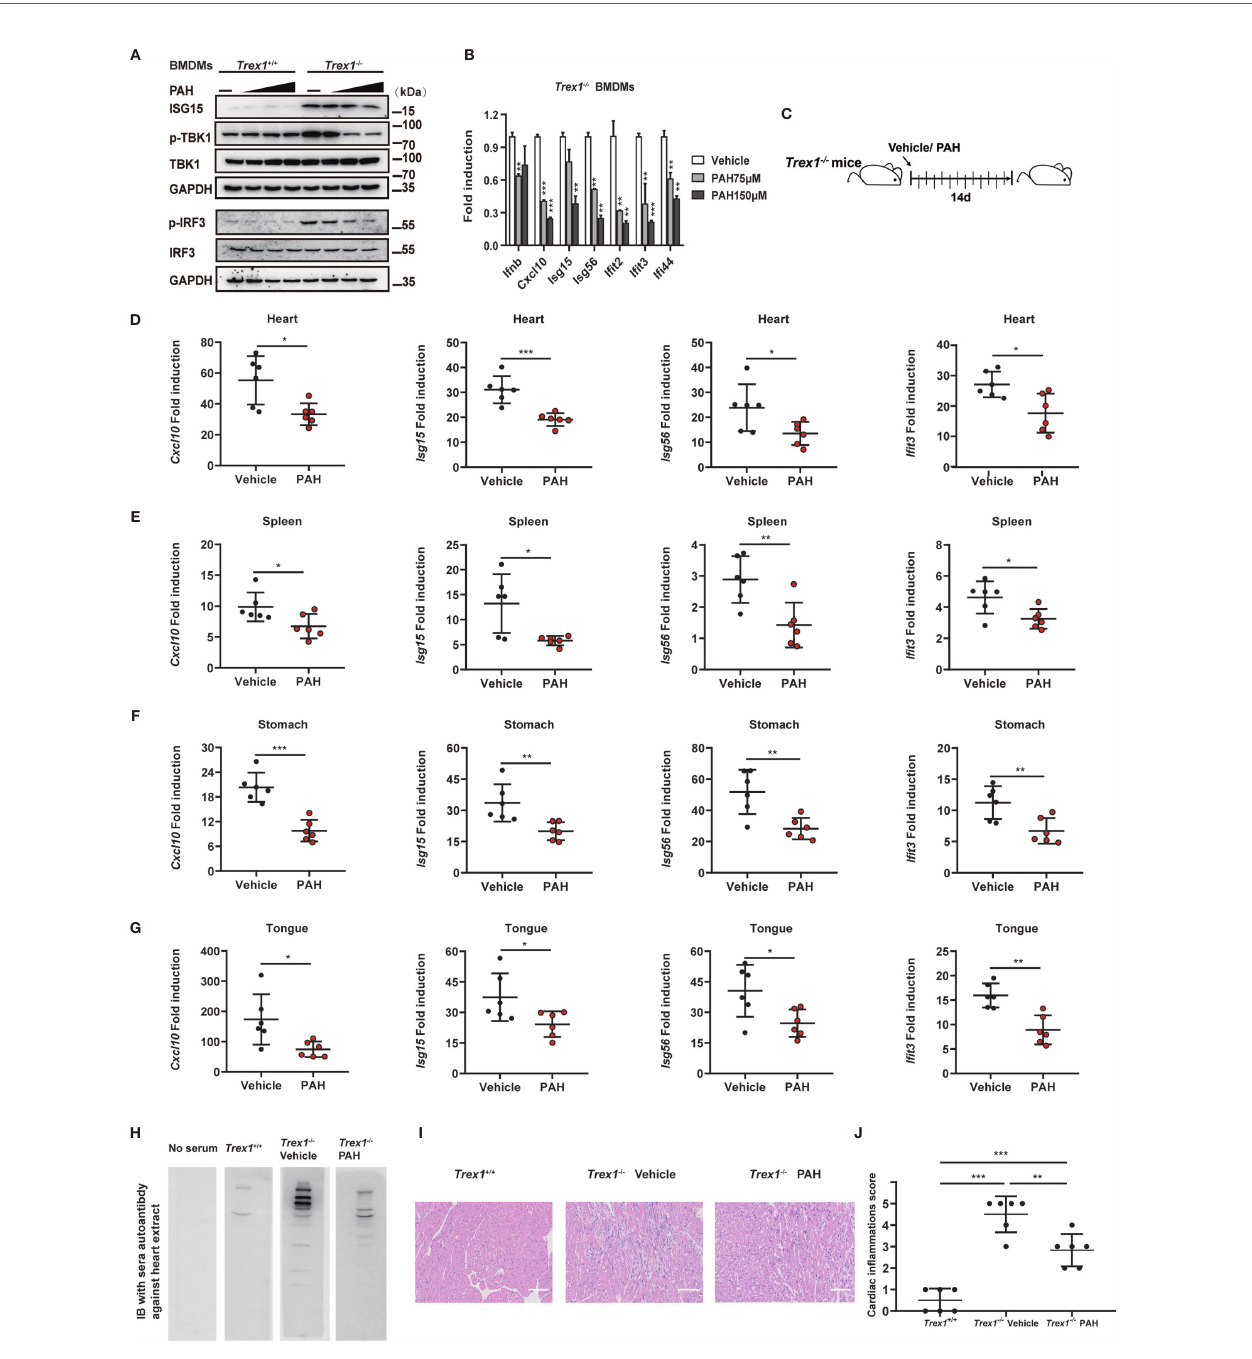
FIGURE 6 | PAH inhibits cGAS-mediated autoimmunity in mice. (A) BMDMs from Trex1 +/+ or Trex1 − / − mice were treated with different PAH doses (0 to 250 m M) for 6 h, then the cell lysates were immunoblotted with the indicated antibodies. (B) BMDMs from Trex1 − / − mice were treated with indicated concentrations of PAH. The baseline of Ifnb , Cxcl10 , Isg15 , Isg56 , I fi t2 , I fi t3 , and I fi 44 mRNA expression was then measured by qPCR. (C) Schematic of Trex1 − / − mice drug administration in vivo. 4 weeks old Trex1 − / − mice were orally administered Vehicle (0.03% CMC-Na solution) or 120 mg (cid:129) kg − 1 PAH once per day for 14 days. (D – G) The levels of Cxcl10 , Isg15 , Isg56 , and I fi t3 mRNA expression in the heart (D) , spleen (E) , stomach (F) , and tongue (G) of mice treated in (C) were measured by qPCR. (H) Representative autoantibodies blotting band of heart extracts from WT mice. Heart extracts were blotted with serum from Trex1 +/+ , Trex1 − / − (Vehicle), and Trex1 − / − (PAH) mice and detected using HRP-conjugated anti-mouse IgG. (I) Representative H&E-stained heart tissue sections from Trex1 +/+ , Trex1 – / – (Vehicle), and Trex1 – / – (PAH) mice. Scale bars represent 100 m m. (J) Pathological scores of cardiac in fl ammations in Trex1 − / − mice administrated with the Vehicle or PAH for 14 days. Data in (A, B) were repeated at least three times, data in (D – J) are representative of two independent experiments. Data in (B, D – G) are presented as mean ± SD. * P < 0.05, ** P < 0.01, *** P <